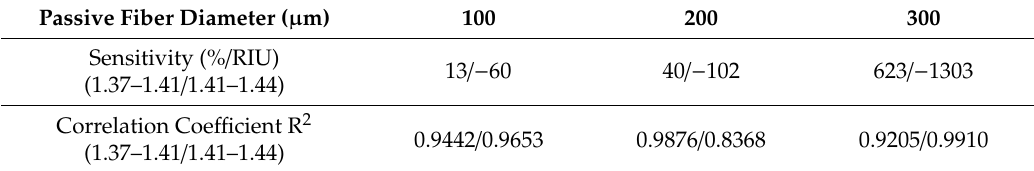
Figure 6. RI sensing performances for the sensors with the active fiber diameter of 300 µ m and passive fiber diameters 100, 200, and 300 µ m, respectively. The twisted region length was 12 mm. Table 3. The sensitivity results from Figure 6.